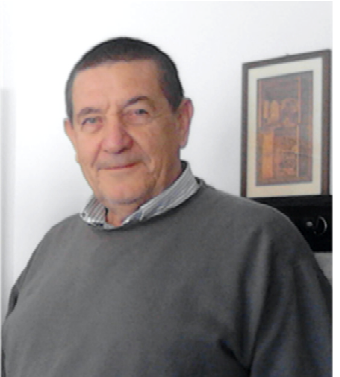
Figure 1. Professor Riccardo Zanasi.